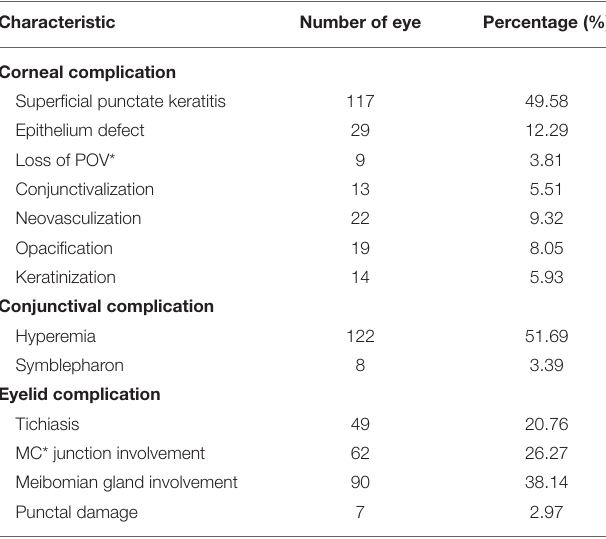
( Table 4 ). The average acute stage score for patients who received additional systemic etanercept was 1.32 ± 0.76 (0–3). The value for patients who received systemic corticosteroid only treatment was 1.49 ± 0.90 (0–3; p = 0.171). In the chronic stage, the average score for additional etanercept treated patients was 1.64